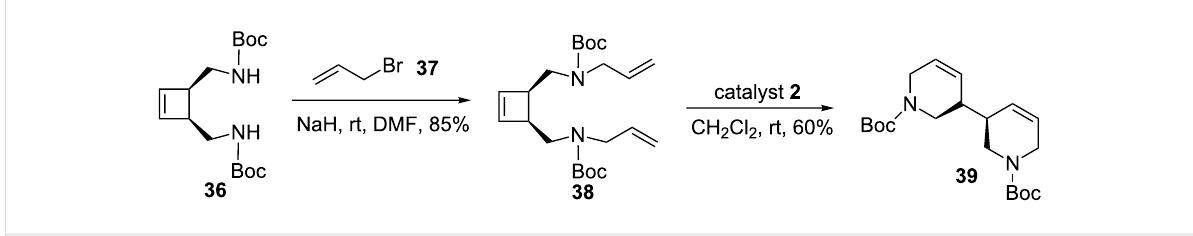
Scheme 5: RRM of cyclobutene system with catalyst 2 .